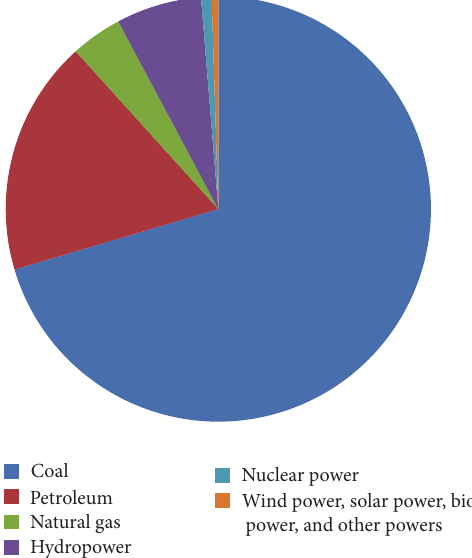
Figure 1: China energy consumption in 2009. Source: China energy statistical yearbook